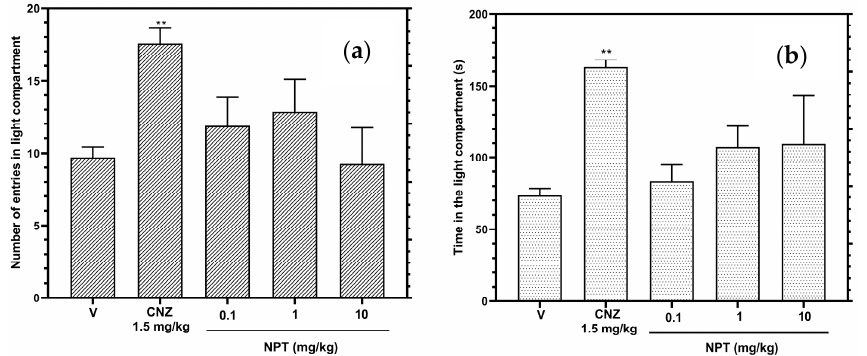
Figure 2. Anxiolytic-like actions of NPT (0.1–10 mg/kg p.o.) in the LDBT were determined by the time in the light compartment ( a ) and the number of crossings into the light compartment ( b ). The reference drug was 1.5 mg/kg p.o. clonazepam (CNZ). Bars represent mean values (±SEM) for the experimental group. n = 8, ** p < 0.05 compared to the vehicle group (indicated as V). In the elevated plus-maze test (EPMT), only the high dose of NPT (10 mg/kg), com- pared to the vehicle group, increased ( p < 0.05) the time in open arms and decreased ( p < 0.05) the number of entries and time in closed arms (Figure 3b,d); however, this same dose did not affect the number of entries in open arms (Figure 3a). The anxiolytic-like effect presented by NPT was lower than that presented by